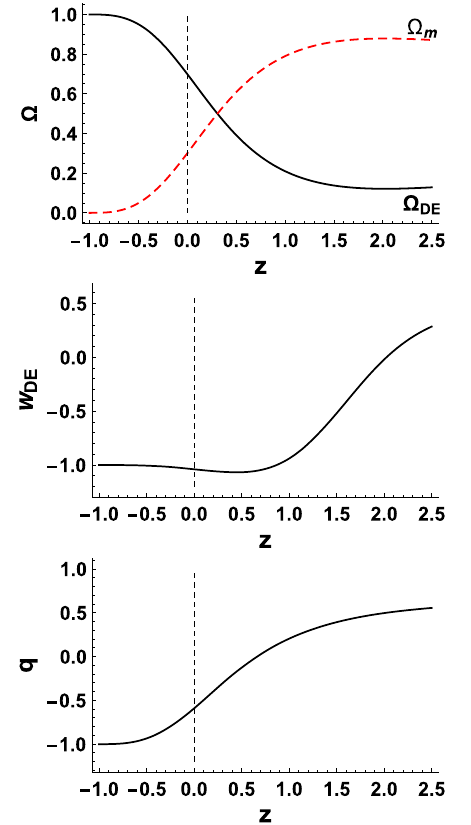
Fig. 1 Upper graph: The evolution of the nonextensive dark energy density parameter (cid:4) DE (black-solid) and of the matter density param- eter (cid:4) m (red-dashed), as a function of the redshift z , for δ = 1 . 1 and α = 1 in units where H = 1. Middle graph: The evolution of the 0 corresponding dark-energy equation-of-state parameter w DE . Lower graph: The evolution of the corresponding deceleration parameter q . In all graphs we have set the cosmological constant (cid:3) from (30) in order to obtain (cid:4) m ( z = 0 ) = (cid:4) m 0 ≈ 0 . 3 at present, and we have added a vertical dotted line denoting the present time z = 0